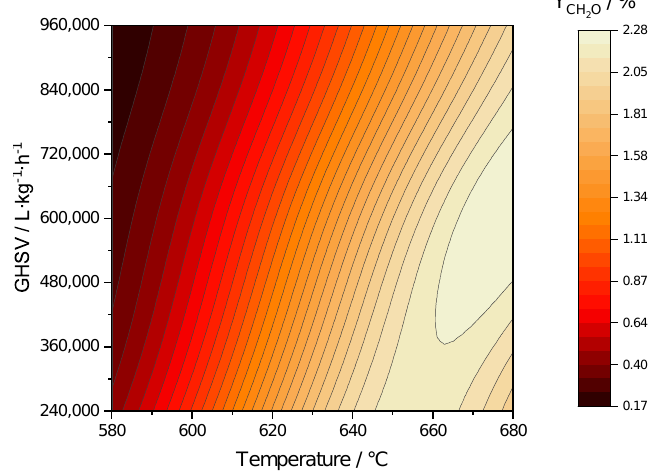
Figure 6. E ff ect of GHSV and temperature on formaldehyde yield at 20% O 2 , 50% N 2 and 20% H 2 O. ◦ − 1 · − 1 The highest yield was predicted at 680 C, 600,000 L · kg h , 20% O 2 , 50% N 2 and 20% H 2 O with 2.3%. In most cases, the yield decreases with increasing GHSV and increases with increasing temperature. Only at higher reaction temperature does the yield decrease with ongoing temperature and lower GHSVs, which is due to overoxidation. A comparison of the predicted yield and the experimental one between ◦ − 1 · − 1 temperatures of 580 and 680 C at 600,000 L · kg h is given in Figure 7.